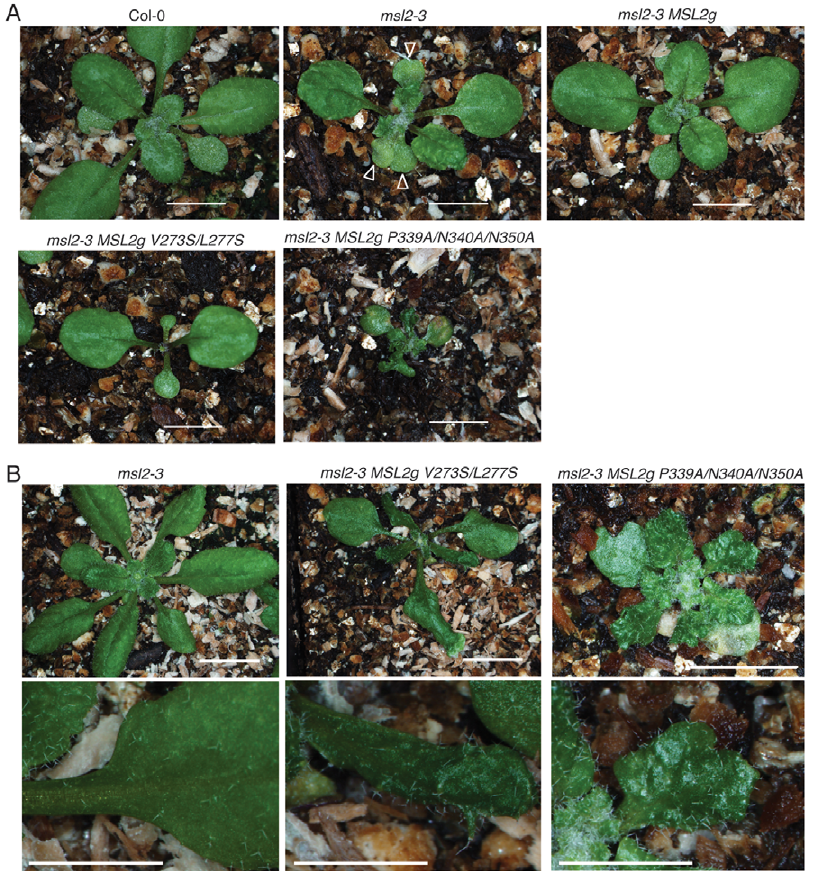
Figure 2. msl2-3 plants expressing MSL2gV273S/L277S or MSL2gP339A/N340A/N350A exhibit dramatic defects in leaf morphology. (A) Representative images of 2 week-old msl2-3 T2 plants transformed with MSL2g variants. Bar is 5 mm. Arrows indicate triple cotyledons in the msl2-3 mutant. (B) Representative images of 3 week-old plants from the indicated lines. Top, bar is 8 mm; bottom, size bar is 4 mm.